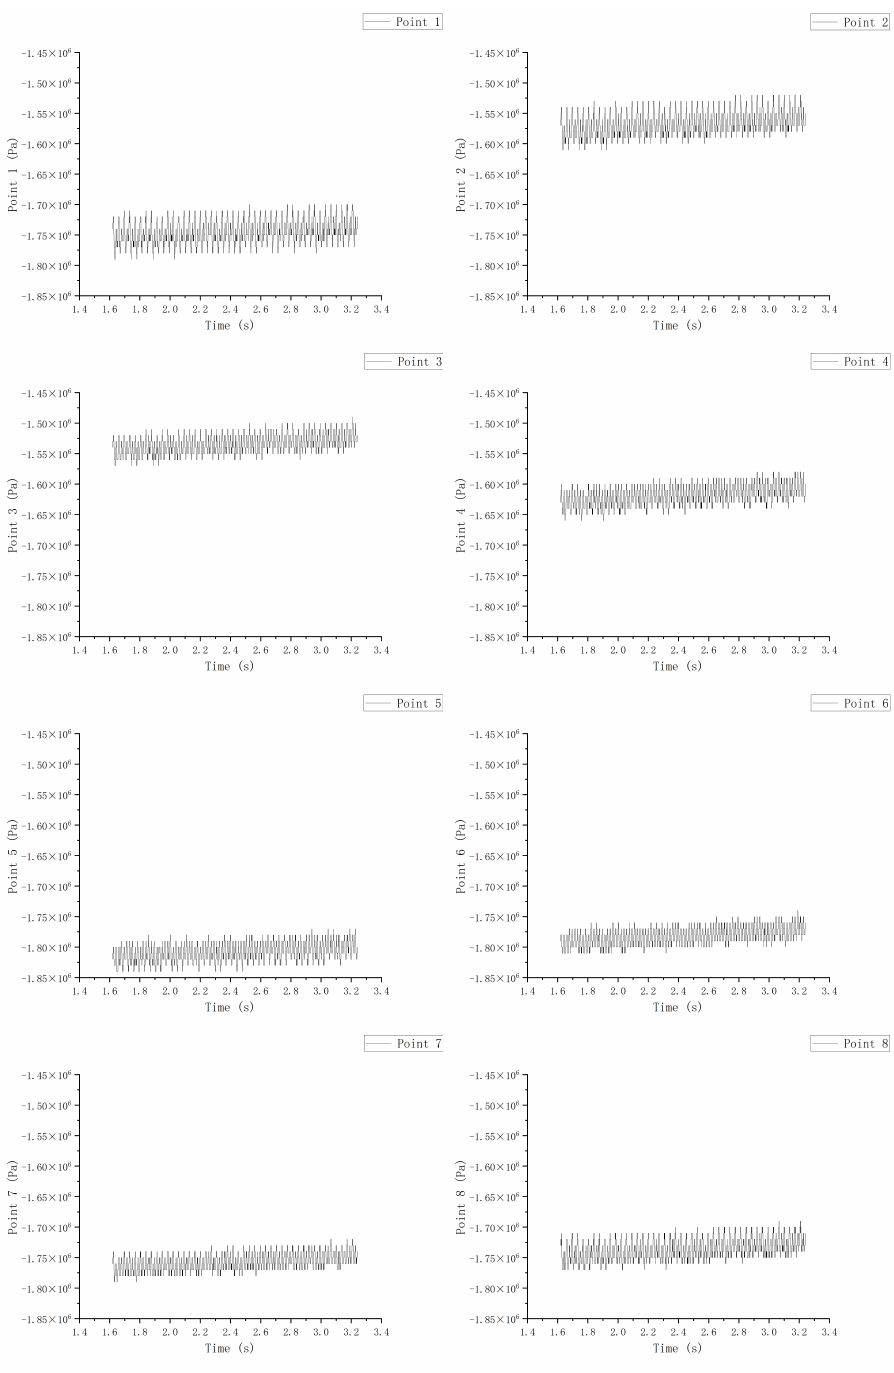
Figure 26. The pressure distributions of the middle bottom ring